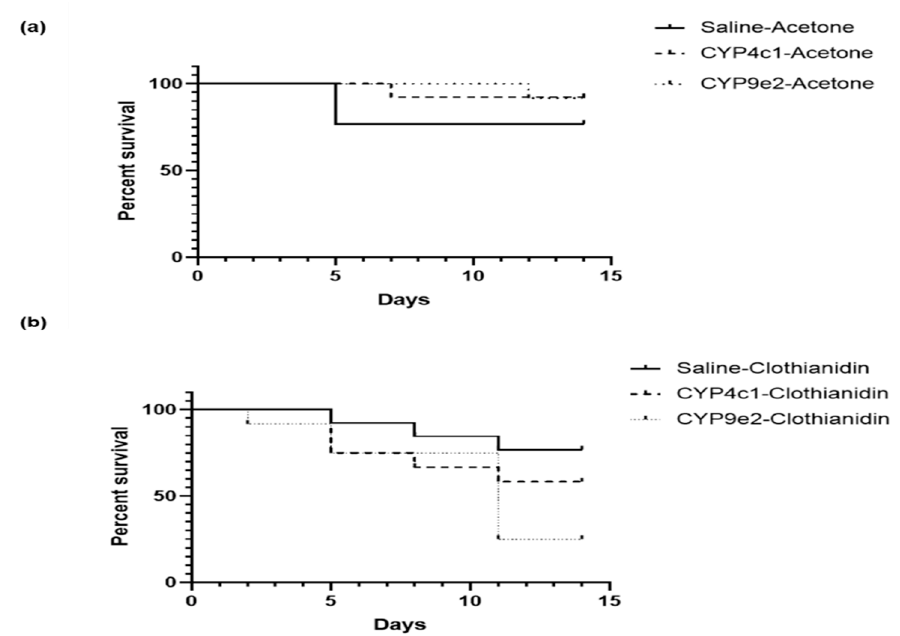
Figure 6. Effect of clothianidin treatment on L. decemlineata in control and dsRNA-injected insects. Kaplan-Meier survival analysis depicts L. decemlineata mortality in saline- or dsRNA-injected insects treated with 0.25 µ g of clothianidin. ( a ) Survival analysis depicting the impact of CYP4c1 and CYP9e2 modulation in insects treated with acetone ( n = 12–13). ( b ) Survival analysis depicting the effect of CYP4c1 and CYP9e2 variation in insects exposed to clothianidin ( n = 12–13).